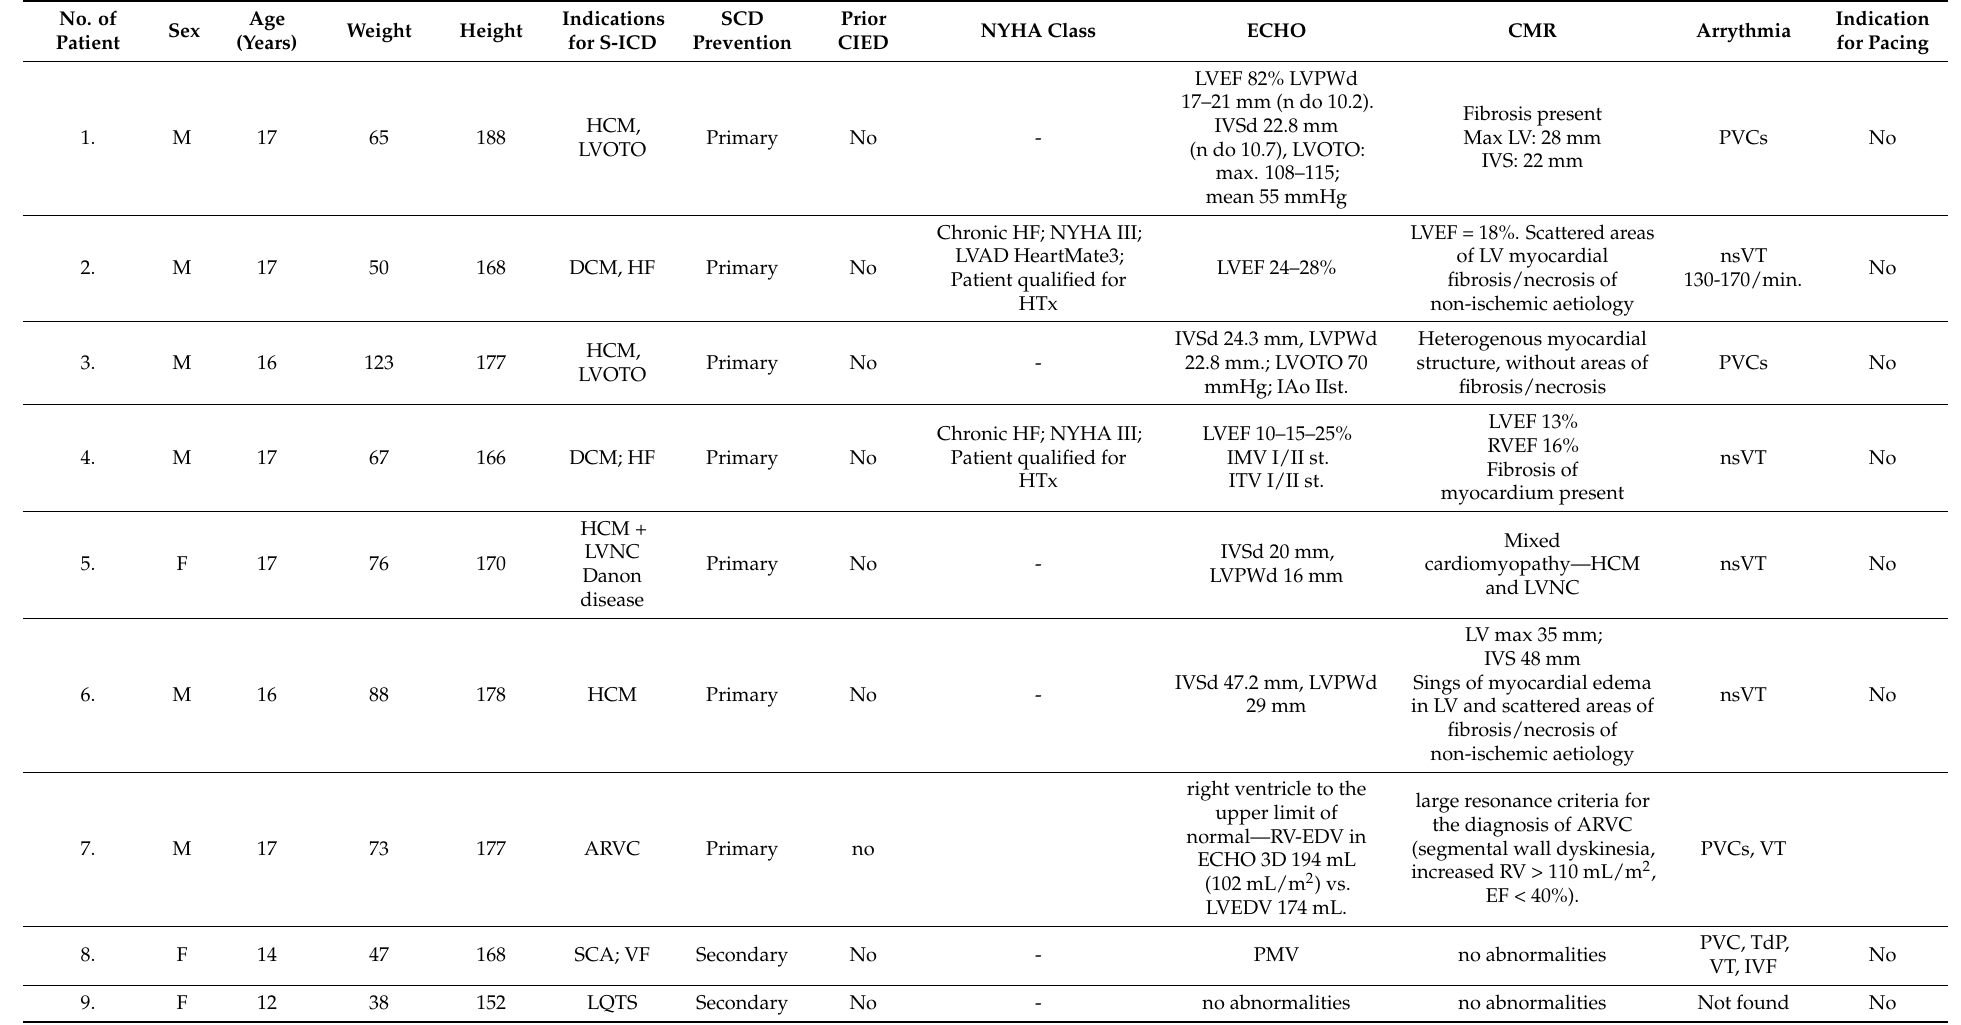
Table 1. Demographics and clinical characteristics of the children’s S-ICD